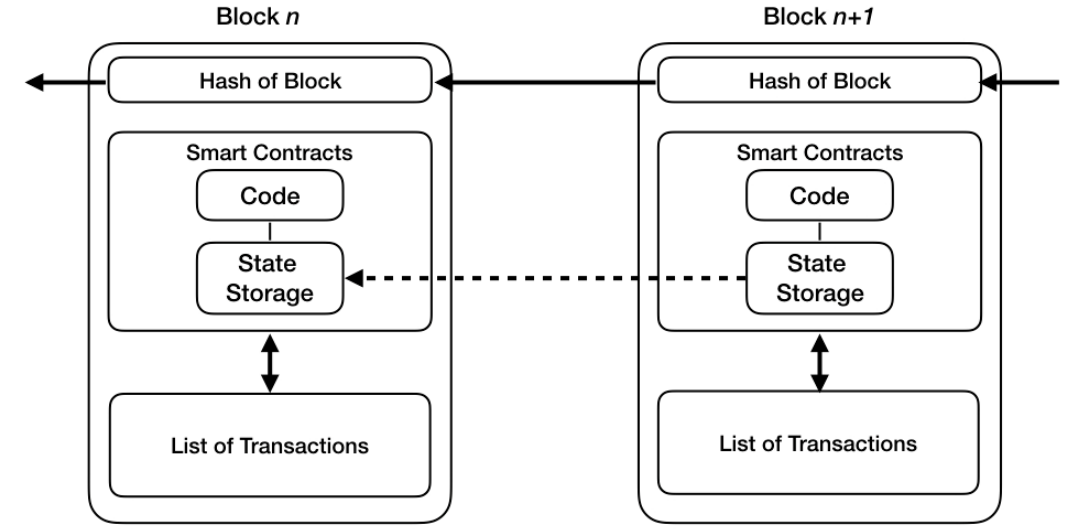
Figure 5. Blockchain software stack on an Etherem node.